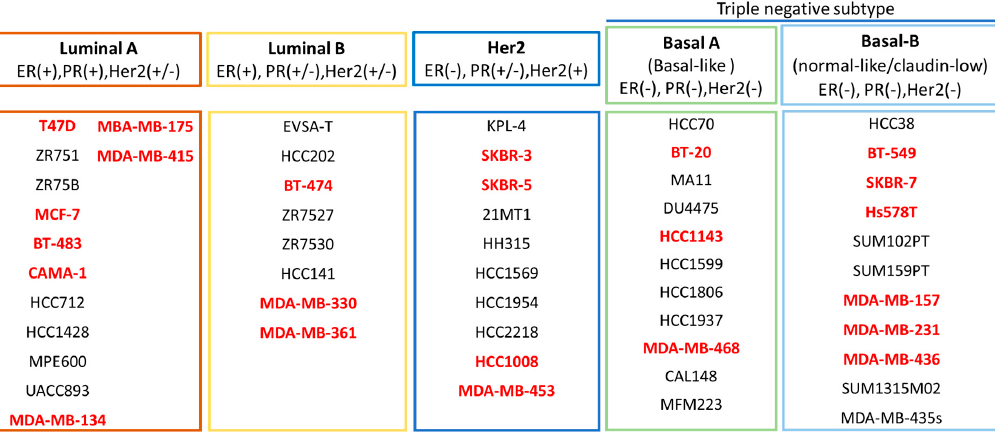
Figure 2. Classifications of the breast cell lines. The cell lines are grouped into Luminal A, Luminal B, Basal-A and Basal B subtypes. Bold red indicates the cell lines that are commonly used for research studies [13–16].